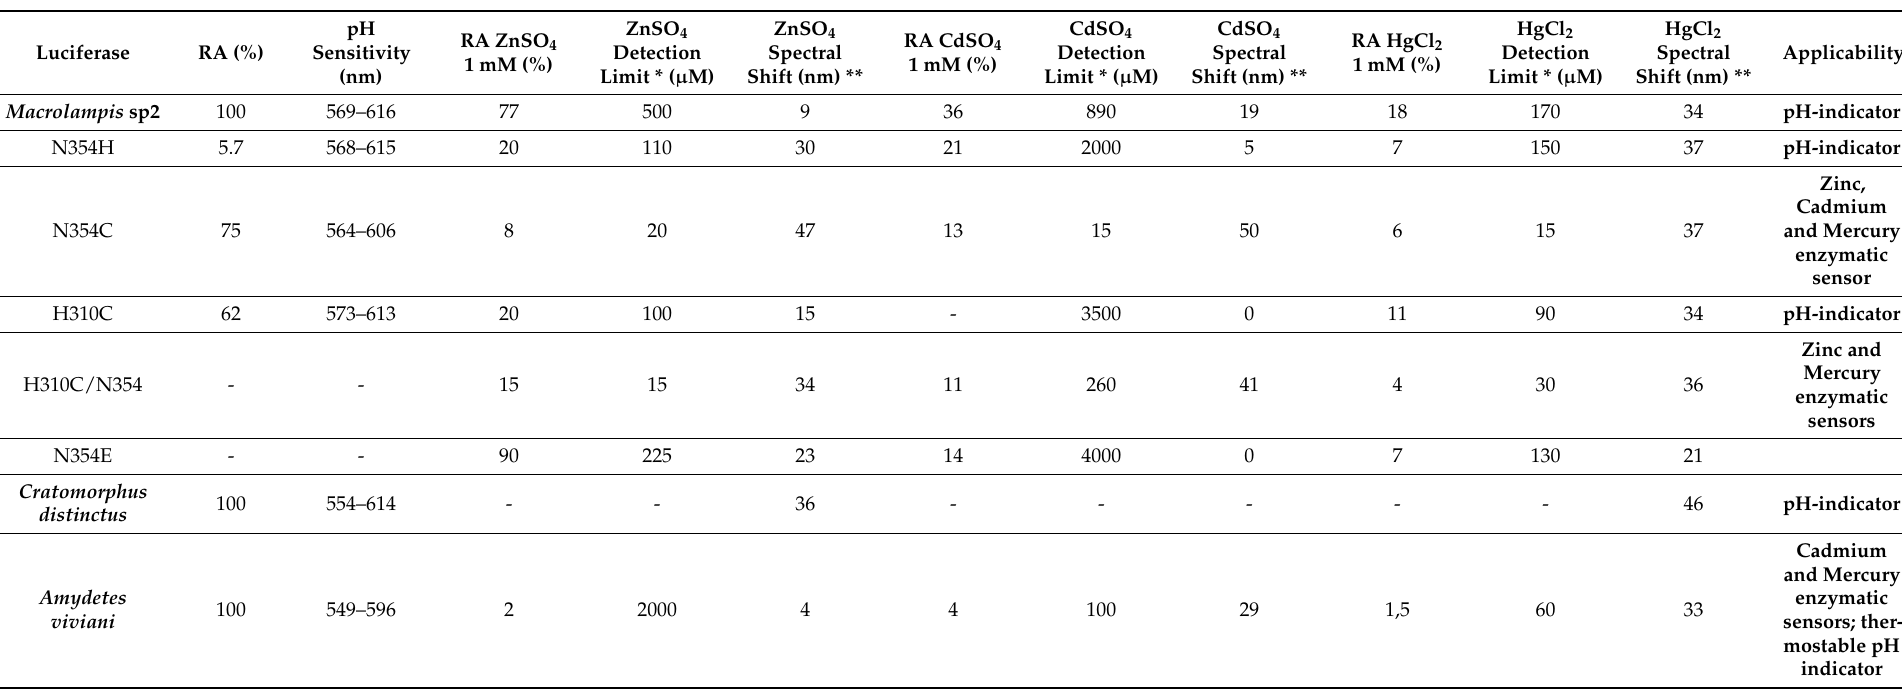
Table 1. pH-sensing and metal binding properties of firefly luciferasesand their engineered forms, and potential